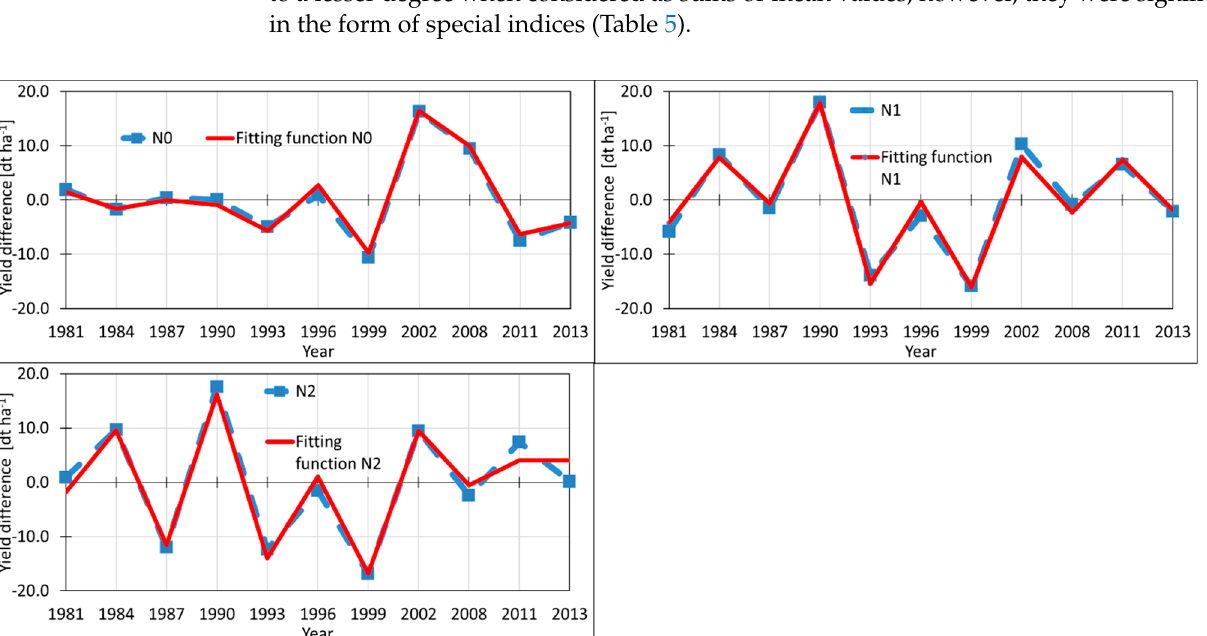
Figure 4. Measured and calculated yields, with monthly independent variables for different fertilization levels (unferti- lized plots (N0), moderately fertilized plots (N1), and highly fertilized plots (N2)). (iv) Regarding the months from which indices were selected, the time spans from October to February were calculated as the most important periods for future growth and, ultimately, the yield. This finding is valid for all indices and all fertilization levels. May and July were also identified as important for plant growth. However, July only occurred in one regression (residual unfertilized) and that too with a low standardized β -coeffi- cient. (v) The role of temperature was evidenced by the parameters temperature threshold and frost-alternating days and, to a less extent, by average temperature (Tm). While the